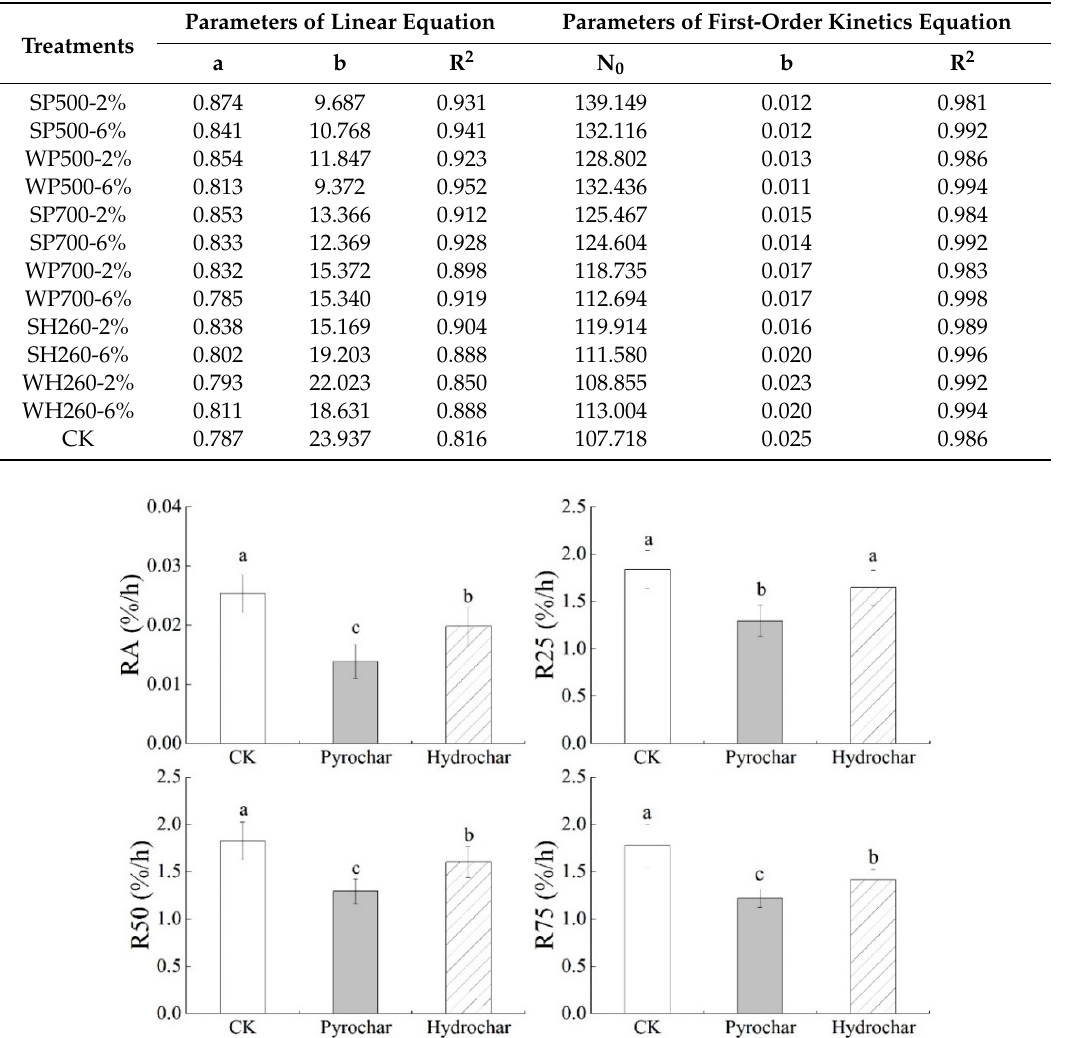
Soil evaporation rate at di ff erent times under pyrochar and hydrochar treatments. RA represents the average soil evaporation (ES) rate. R25, R50, and R75 represent ES rate when water loss reached 25%, 50%, and 75% of the total water. Di ff erent lowercase letters represent statistical di ff erences at p < 0.05. Error bars represent standard deviations.